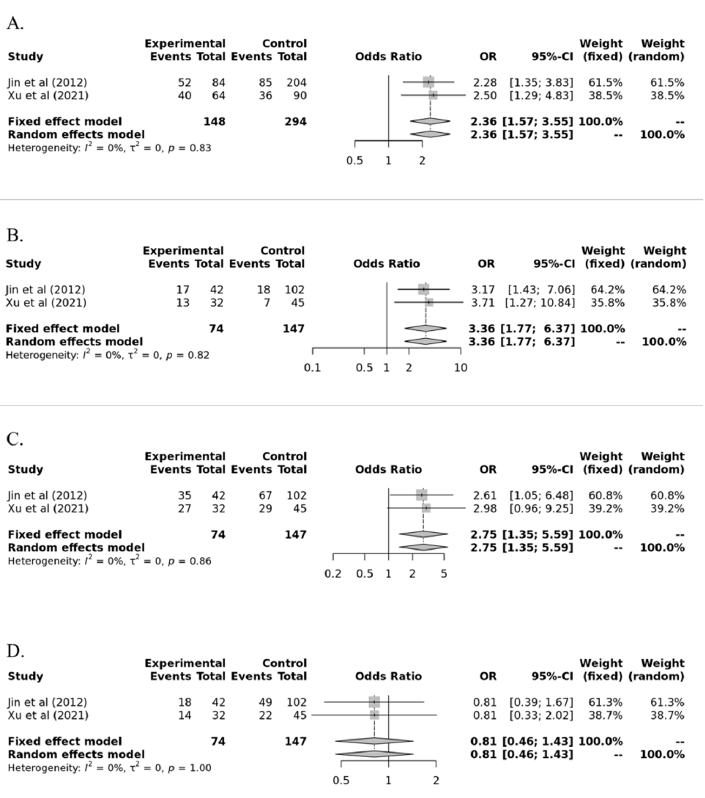
Figure 4. Subgroup analysis between HLA-G polymorphism (14-bp insertion/deletion (rs16375)) and susceptibility to acute rejection in kidney transplant recipients according to nationality. ( A ) Ins vs. Del; ( B ) Ins/Ins vs. Ins/Del+Del/Del; ( C ) Ins/Ins+Ins/Del vs. Del/Del; ( D ) Ins/Del vs. Ins/Ins+Del/Del.